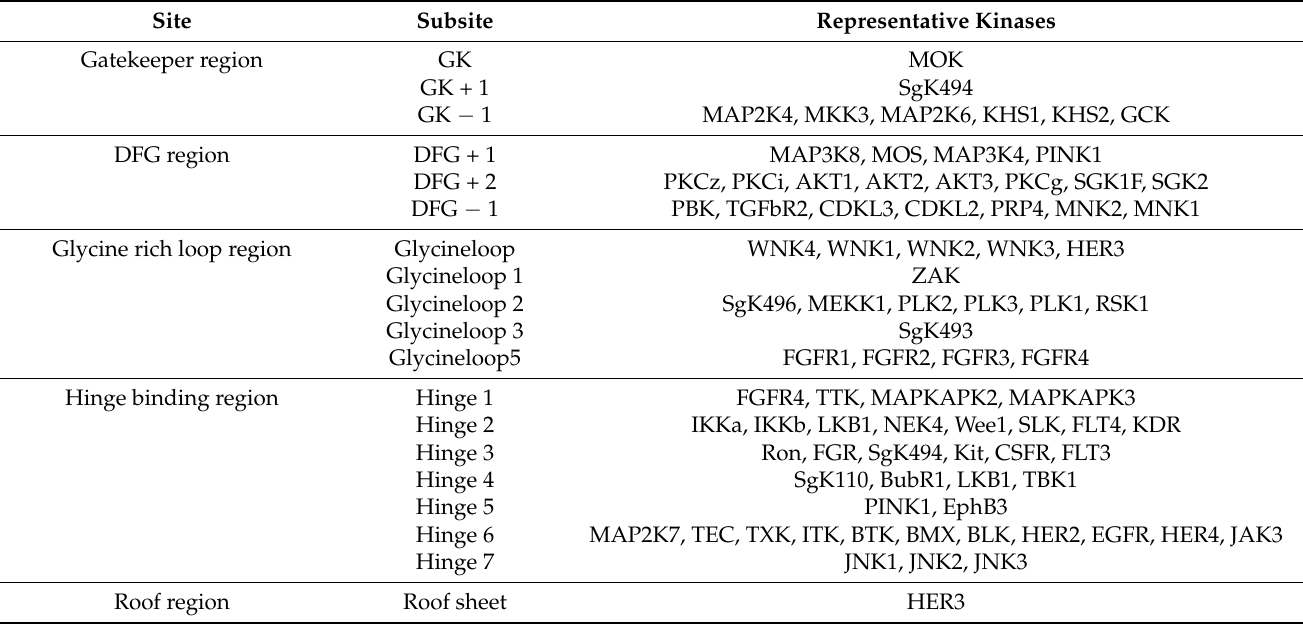
Table 2. Kinase cysteinome classification. Summarized from [73]. Bold highlights kinases representing the main tyrosine kinase targets of withaferin A. Site Subsite Representative Kinases Gatekeeper